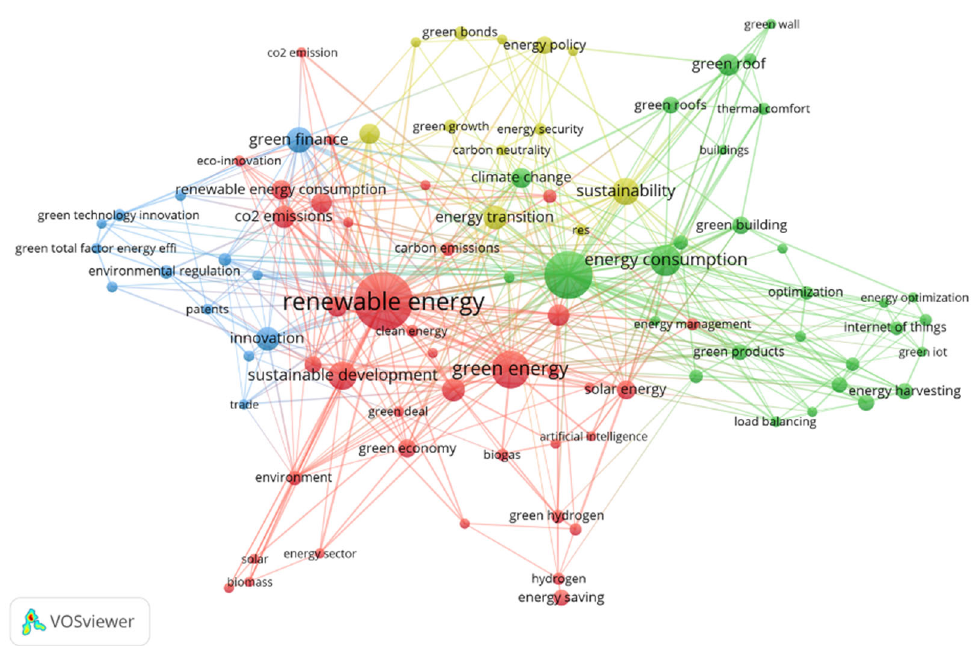
Figure 8. Co ‐ occurrence map (keywords network). Figure 8. Co-occurrence map (keywords